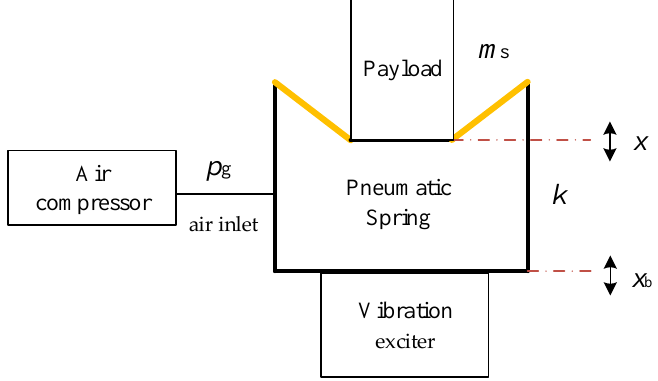
Figure 5. The test model of the pneumatic vibration isolation. During the real work state, the pneumatic spring equals a passive suspension. The damping of the system is ignored. The analysis model of the pneumatic spring working process is set up in a MATLAB/Simulink environment. According to Equations (10), (11), (16) and (17), four integrated computing modules are established, which are dynamic anal- ysis, natural frequency analysis, transmission rate analysis, and rubber stiffness analysis. In this simulation, five parameters, including L 1 , D 1 , D 2 , m g (directly influence the pressure p g ), and m s , are set as input variables. The evaluating values such as velocity, displacement, natural frequency, and transmission rate are the outputs of the